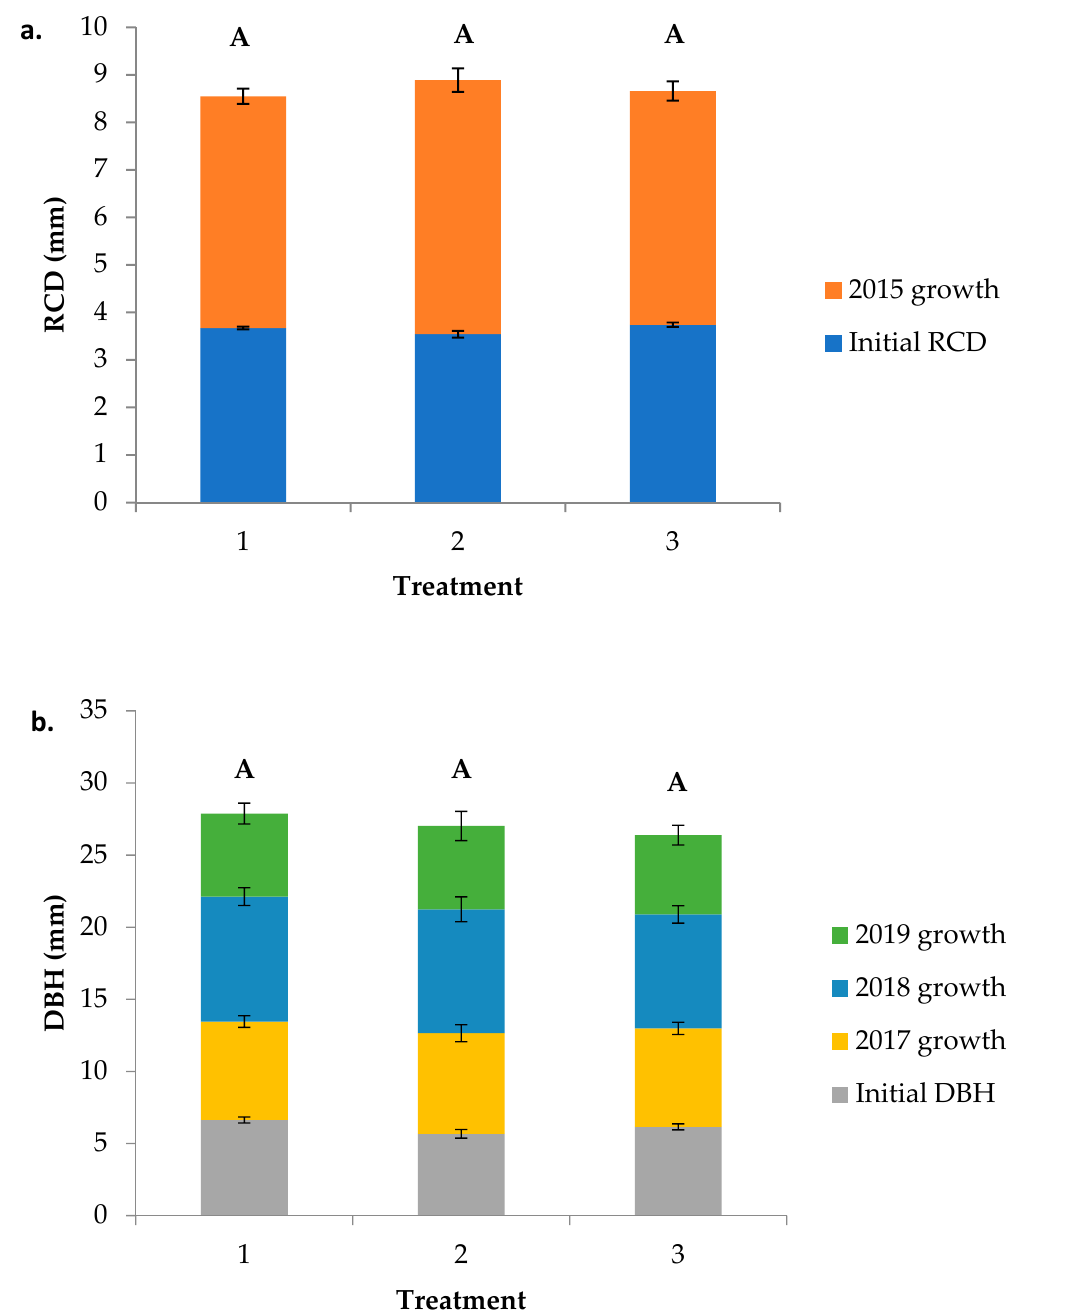
Figure 5. Mean initial diameter and mean annual growth increment ( ± SE) (year 1 = 2015 growth; year 2 = 2016 growth; year 3 = 2017 growth; year 4 = 2018 growth; year 5 = 2019 growth) (cm) ( ± SE) for balsam poplar trees planted in three treatments (1 = 25 selected tolerant clones, 2 = 10 selected control clones, 3 = Stream 1 veg. lot clones). ( a ) Basal root collar diameter (RCD mm) (2014–2015); ( b ) diameter at breast height (DBH mm) (2016–2019). Significant differences between treatment means for DBH are indicated by different letters at p ≤ 0.05.